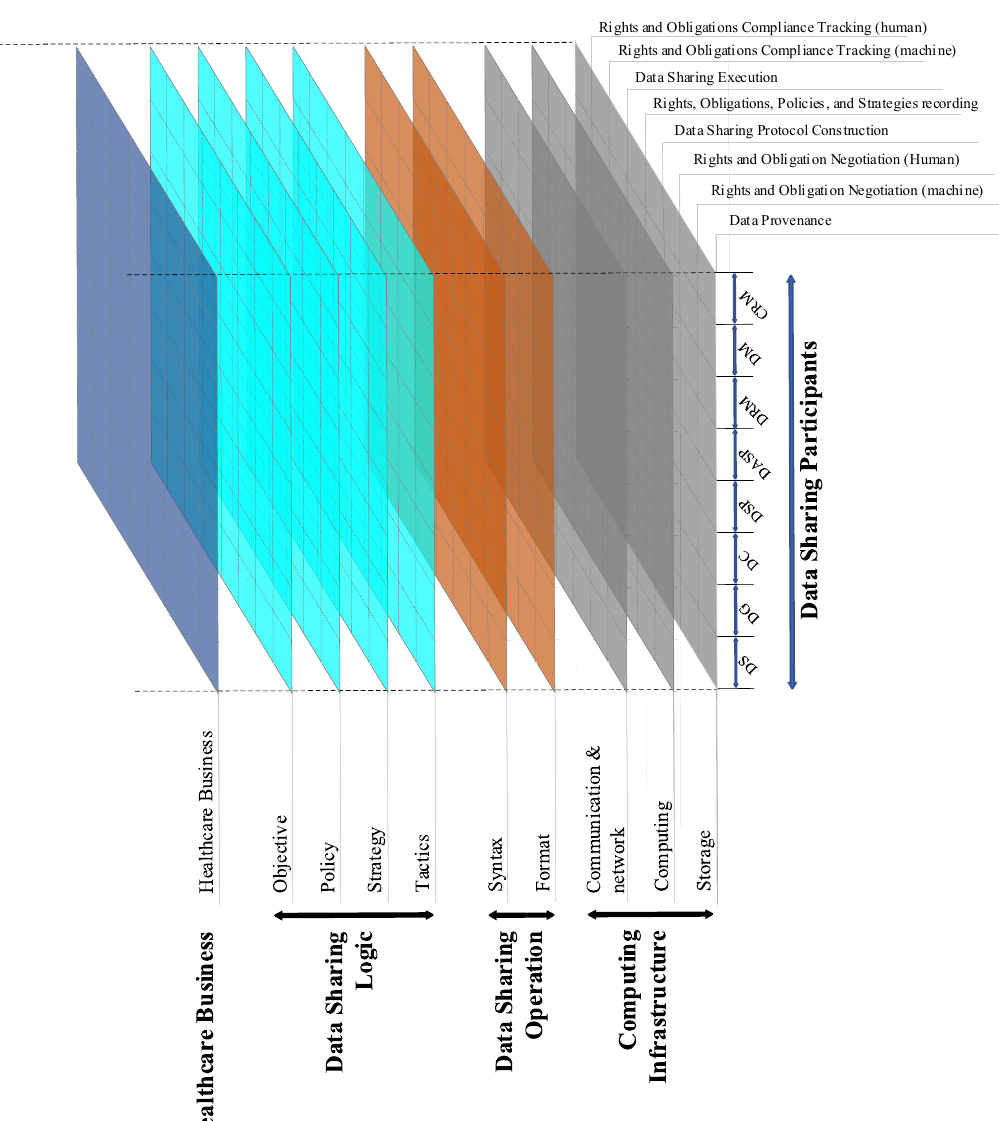
Figure 1. Conceptual Layered Architecture of HD platform.